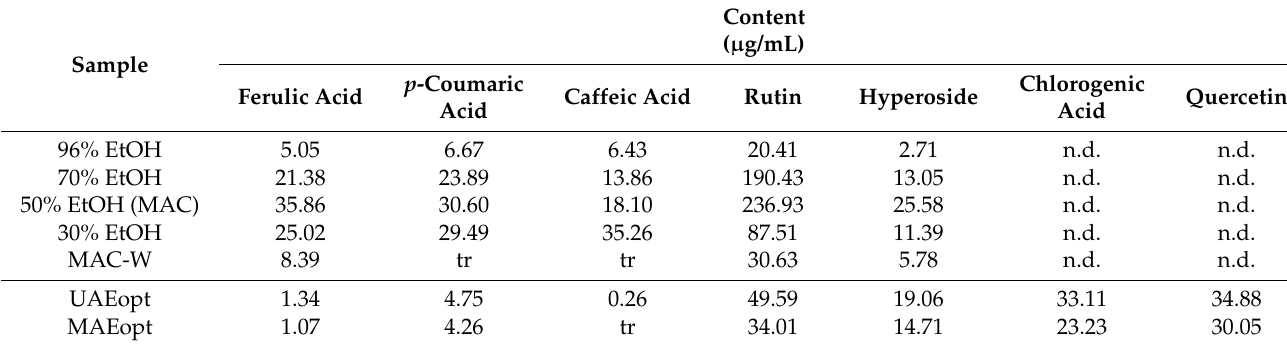
Table 4. HPLC-DAD analyses of ethanol, water, UAEopt and MAEopt horehound